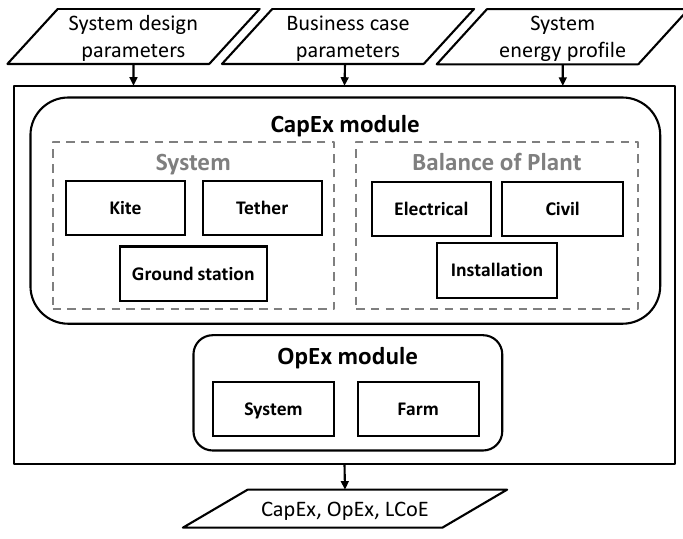
Figure 4. Components of the cost